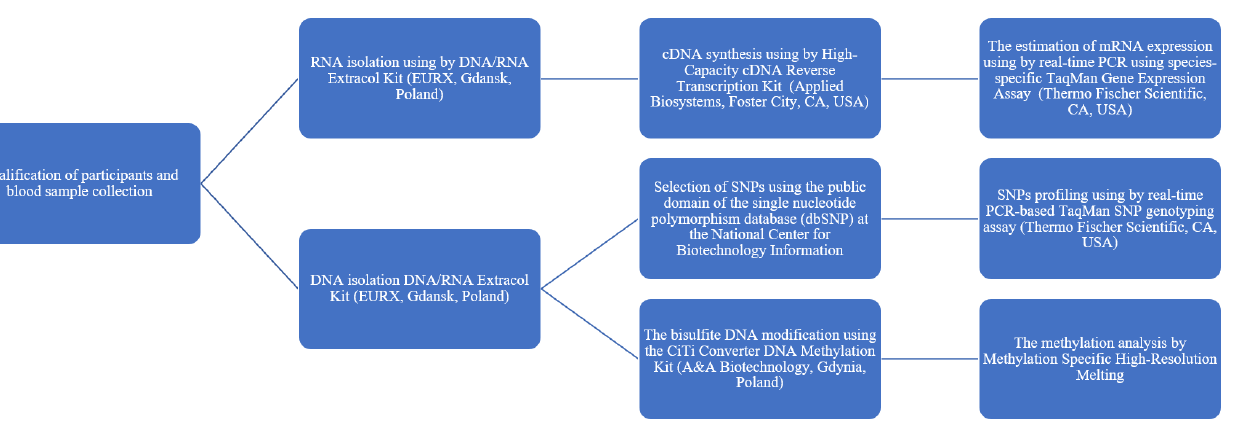
Table 5. Basic information on the IL-6 and IL-8 polymorphic variants.